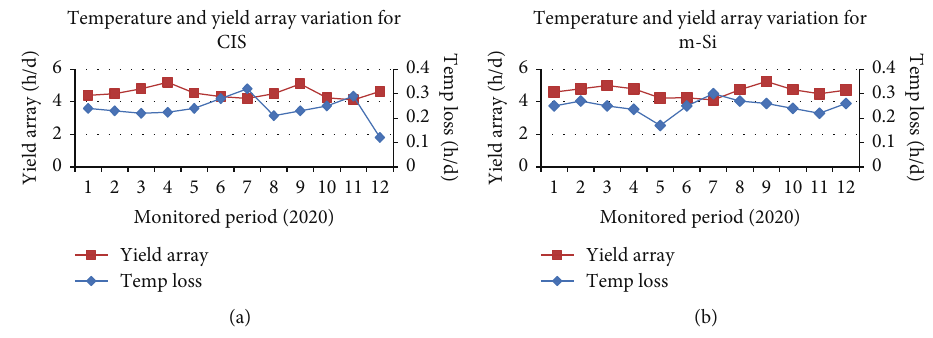
Figure 5: Temp loss and yield array for (a) CIS and (b) m-Si.